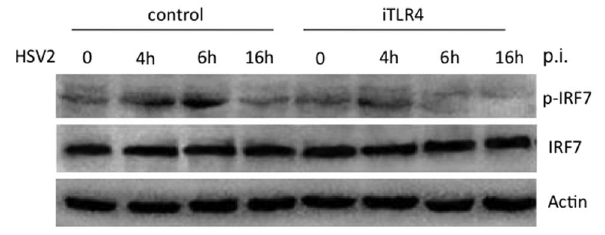
Figure 3. TLR4 mediates the phosphorylation of IRF7 in response to HSV-2. HCE cells were transfected with scrambled shRNA control or iTLR4. Forty-eight hours after transfection, cells were infected with HSV-2 at 3 MOI or mock-infected. Cell lysates were collected at 0 h, 4 h, 6 h, 16 h post-infection and analyzed by Western blotting with antibodies against p-IRF7, total IRF7 and Actin. Knockdown of TLR4 decreased the phosphorylation of IRF7 by HSV2 infection. The experiment was repeated three times, the representative images from one experiment are shown.